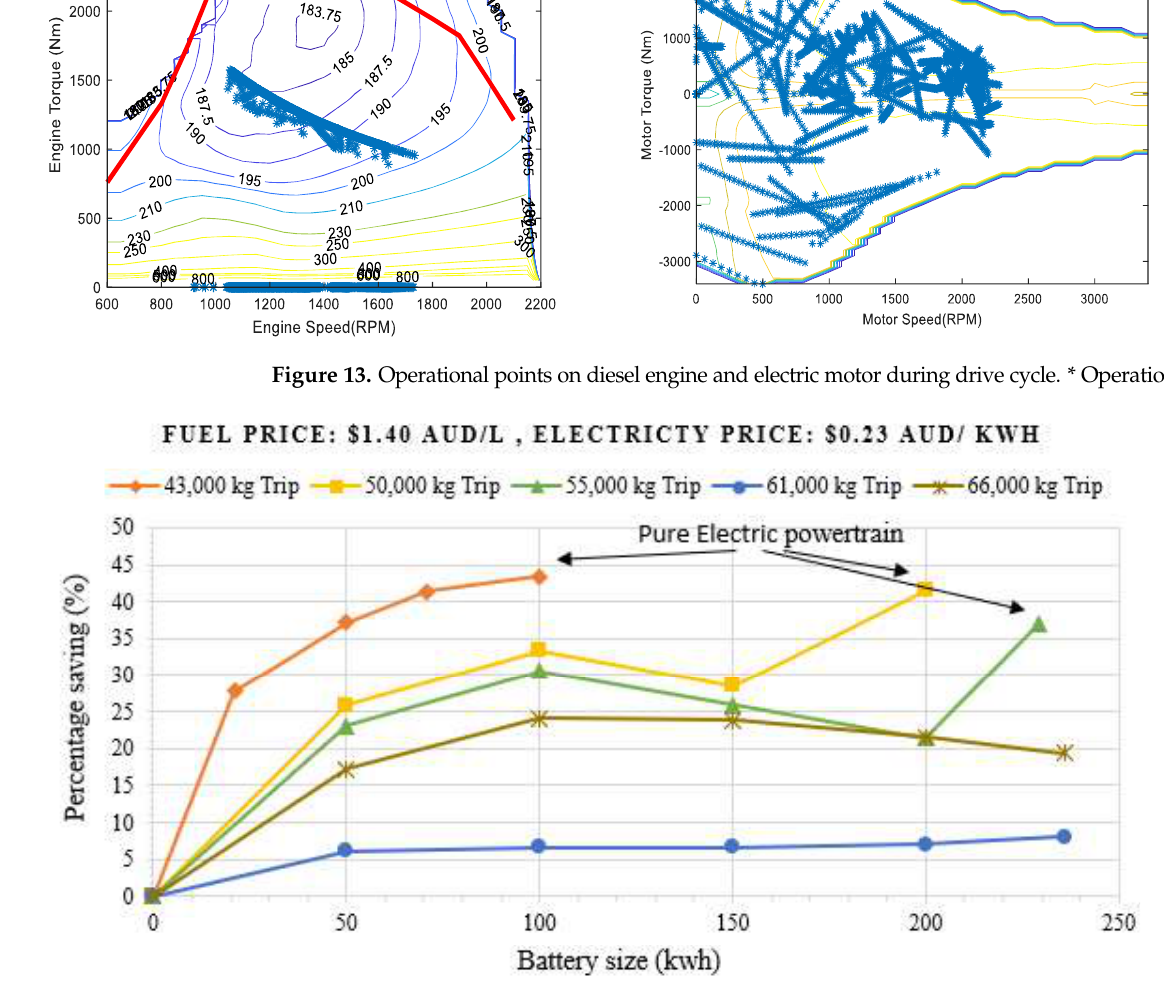
Figure 13. Operational points on diesel engine and electric motor during drive cycle. * Operational point.